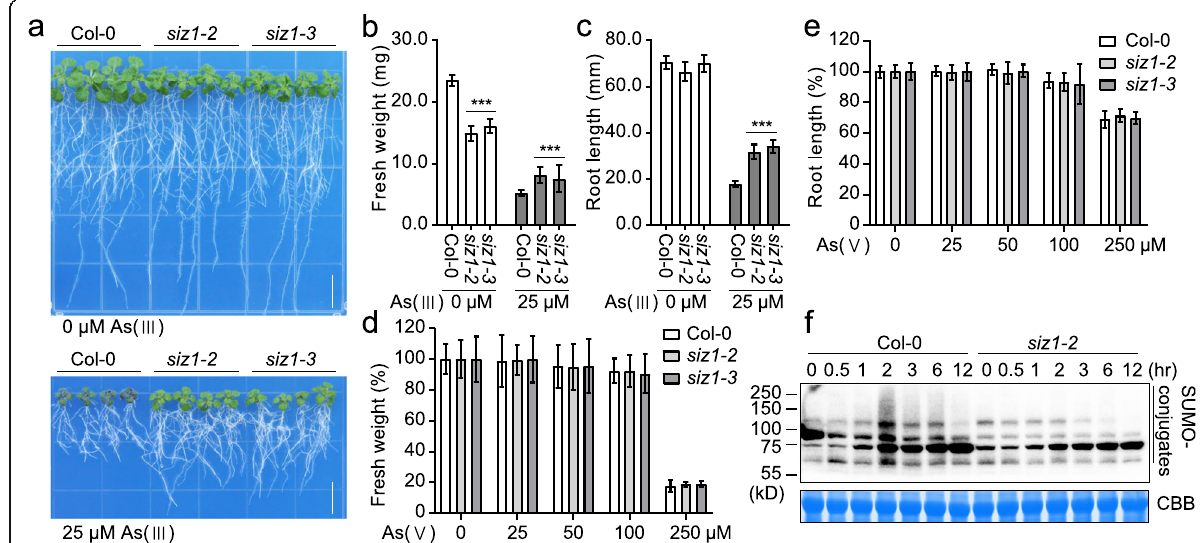
Fig. 1 SIZ1 is a negative regulator of arsenite resistance in Arabidopsis. a Arsenite resistance assay of Col-0, siz1 – 2 , and siz1 – 3 seedlings. Five-day- old seedlings grown in 0.5× MS medium were transferred to medium with or without 25 μ M As (III) for additional 12 days. Bar, 1 cm. b , c Fresh weight ( b ) and root length ( c ) of Col-0, siz1 – 2 , and siz1 – 3 seedlings shown in ( a ). d , e Fresh weight ( d ) and root length ( e ) of Col-0, siz1 – 2 , and siz1 – 3 seedlings treated with 0, 25, 50, 100 or 250 μ M As(V). Five-day-old seedlings grown in 0.5× MS medium were transferred to medium with or without As(V) for additional 12 days. Values are means ± SD of three replicates, each replicate containing 9 plants per genotype. *** P < 0.001, Student ’ s t test. f SUMOylation profiles of wild type Col-0 and siz1 – 2 seedlings after As (III) treatment. Ten-day-old Col-0 and siz1 – 2 seedlings grown in 0.5× MS medium were treated with 100 μ M As (III) for the indicated time periods. The SUMOylation profiles were determined by Western blot using anti-SUMO1 antibody. The Coomassie blue (CCB) staining was used as a loading control